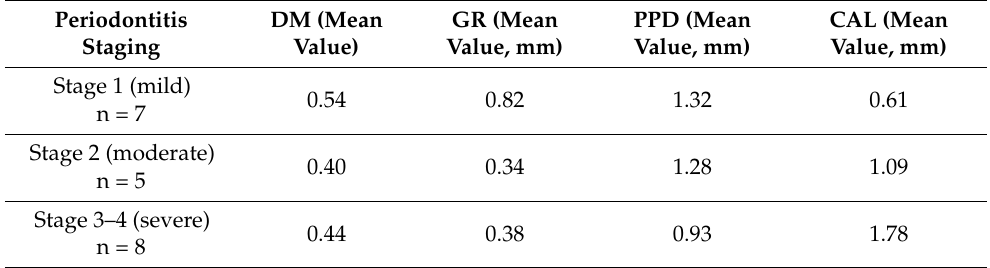
Table 3. Periodontal parameters in the control group in correspondence to periodontitis